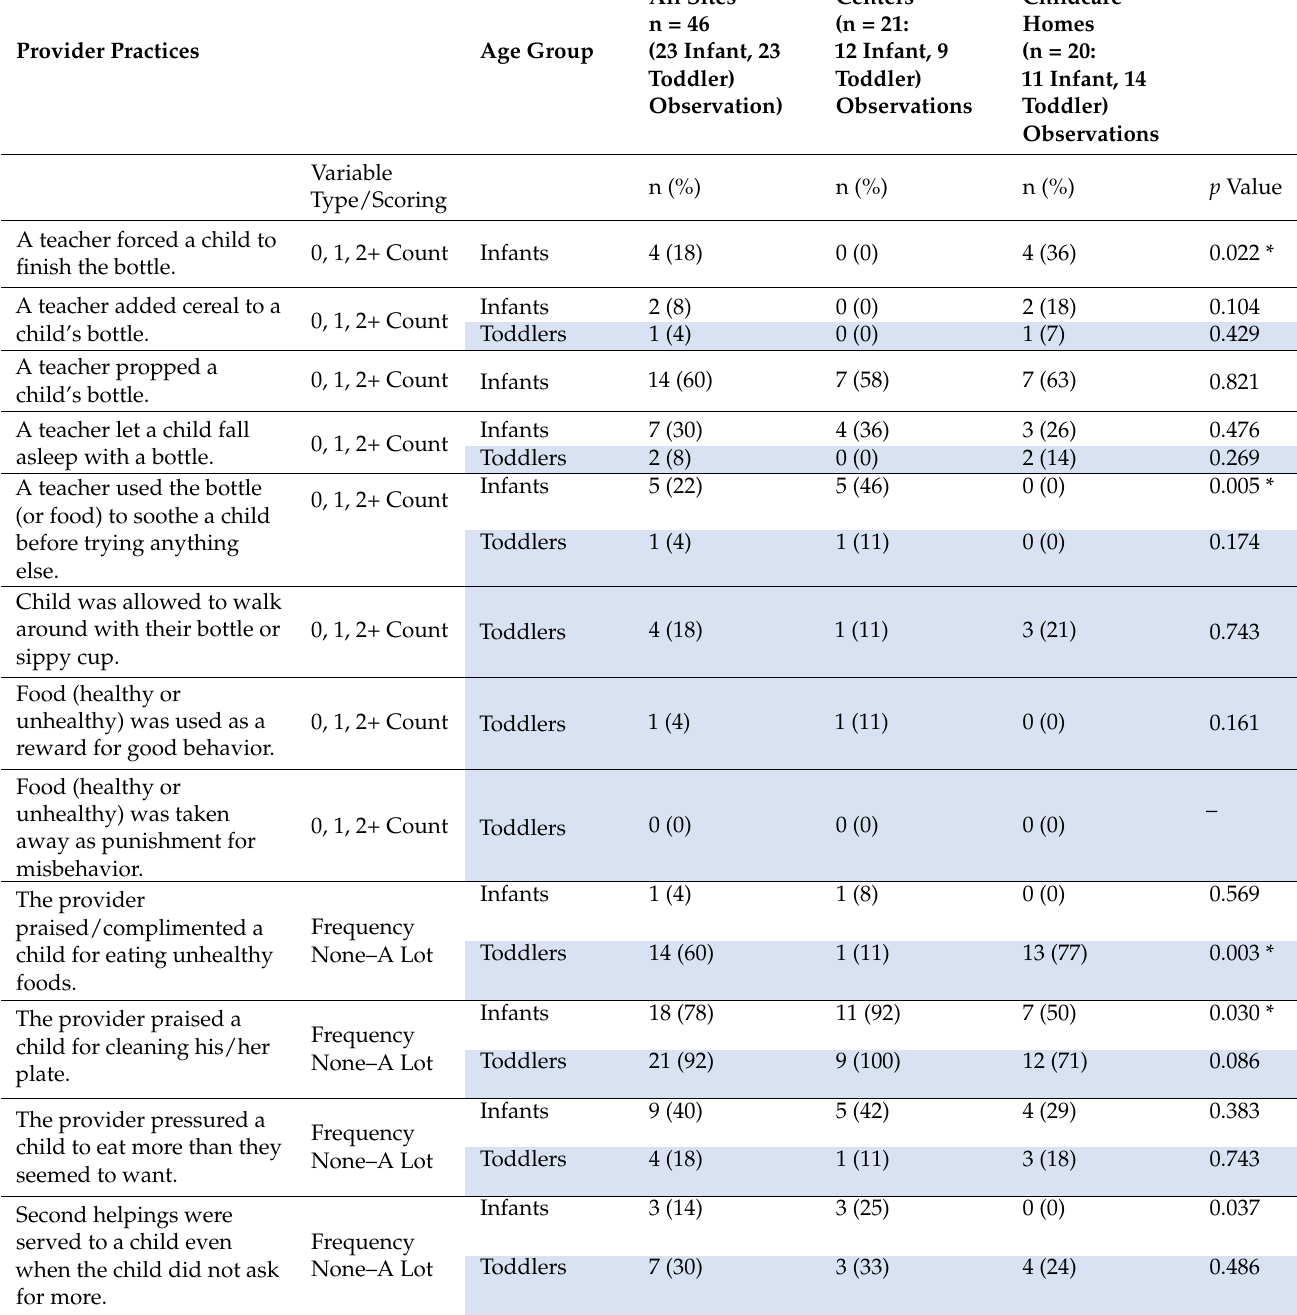
Table 3. Frequency of Non-Recommended Infant and Toddler Feeding Practices in Centers and Family Childcare